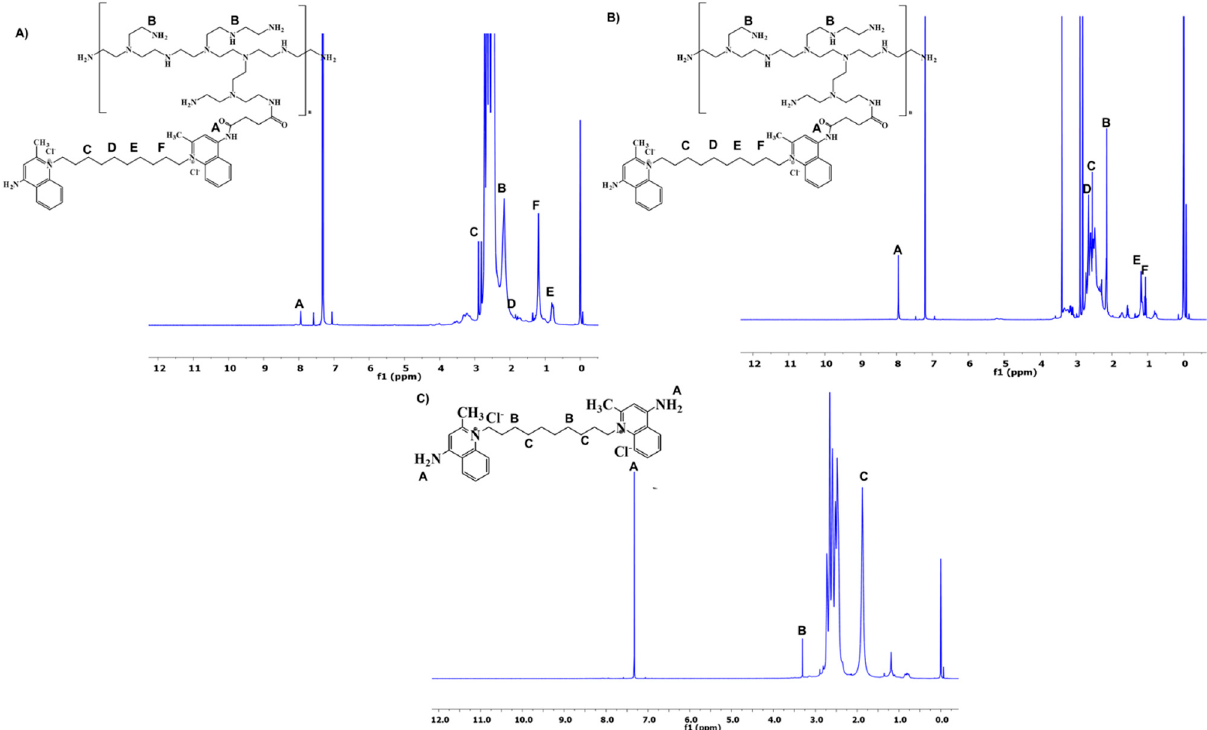
Figure 3. 1 H NMR spectra of PEI–DQA: PEI (10 kDa) ( A ) and PEI (25 kDa) ( B ); the spectrum of DQA ( C ).